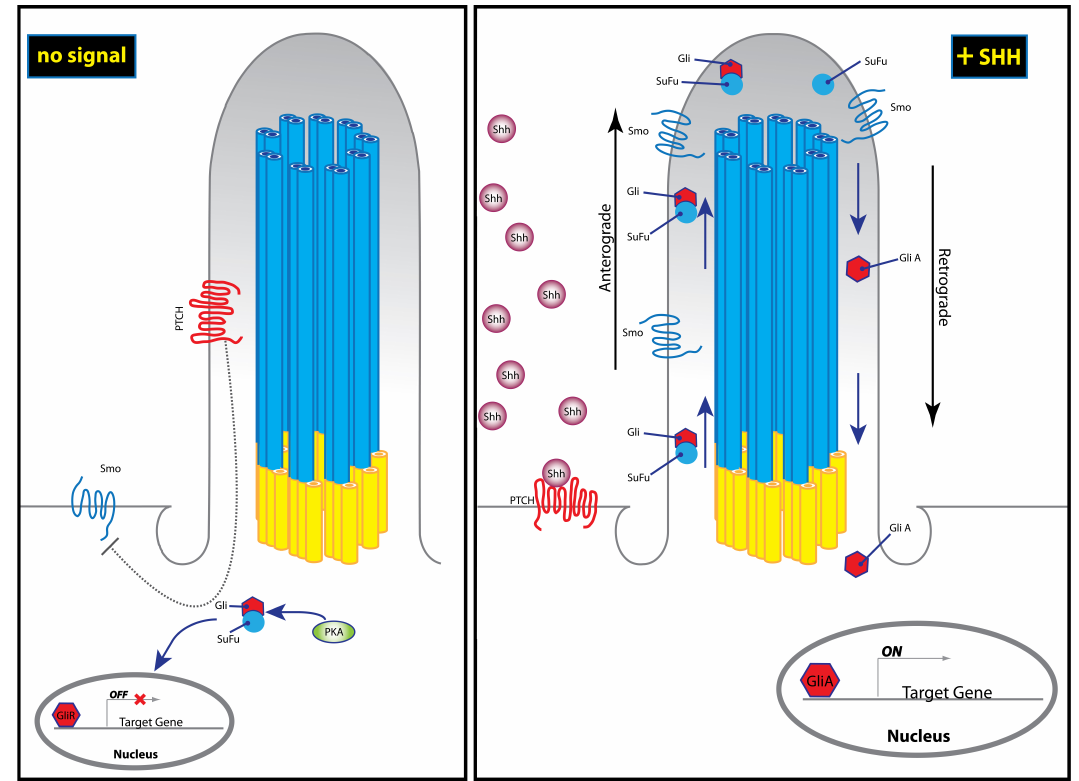
Figure 2. In the absence of Hh signal, Patched1 ( Ptch1) inhibits the Hh pathway through the modulation of the Smoothened (Smo) . Since Smo is inactivated, the Glioma-associated oncogene- Suppressor of Fused ( Gli - Sufu) complex is retained in the cytosol, where it is exposed to phosphorylation by protein kinase A (PKA), thereby inhibiting signal transduction by Gli . When Hh signal is present (here represented by Shh ), its binding to Ptch 1 relives pathway inhibition, induces its translocation away from the cilium, allowing activated Smo and Gli - Sufu complex transport to the tip of the cilium, where Gli becomes dissociated from Sufu . Subsequent retrograde transport of Gli then brings it to the nucleus, where it regulates expression of target genes. Image adapted from Reference